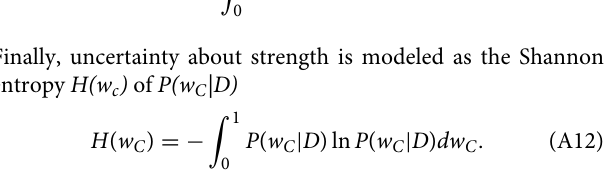
MATLAB code implementing the model using numerical integration is available in the online supplementary